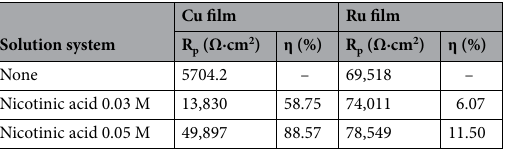
Table 2. Polarization resistance (R p ) and inhibition efficiency (η) of metal films according to inhibitor concentration.